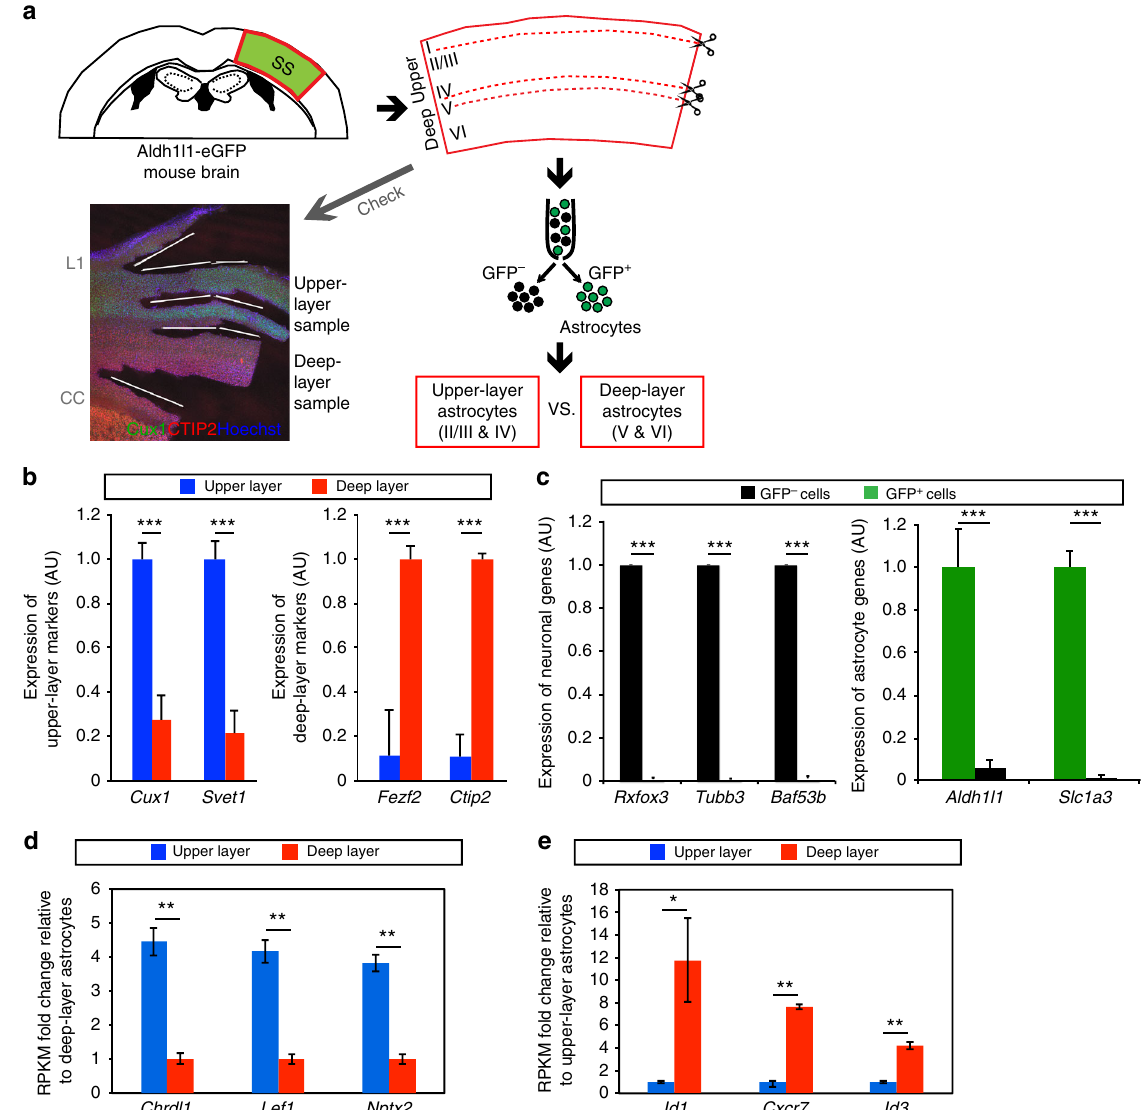
Fig. 4 Layer-speci fi c molecular expression in neocortical astrocytes. a Procedure for the isolation of upper-layer (ULAs) and deep-layer (DLAs) astrocytes for comparison of their gene expression levels. Layer I (L1), the boundary between layers IV and V, and the corpus callosum (CC) are discarded from the somatosensory (SS) area of the brain of young adult Aldh1l1-eGFP transgenic mice in which astrocytes are labeled with GFP and can therefore be isolated by FACS. The fl uorescence image is of a coronal section stained with antibodies to Cux1 and to CTIP2, as well as with Hoechst 33342. b RT-qPCR analysis of upper-layer ( Cux1 , Svet1 ) and deep-layer ( Fezf2 , Ctip2 ) neuronal marker genes in upper-layer and deep-layer tissue samples. c RT-qPCR analysis of neuronal (left) and astrocytic (right) marker genes in isolated GFP + or GFP − cells. d , e RPKM fold change relative to deep-layer ( d ) and upper-layer ( e ) in expression analyzed by RNA-seq ( n = 3 brains). Top 3 upper-layer enriched and deep-layer enriched genes are shown in d , e , respectively. See Supplementary Data 1 and 2 for full gene lists of upper-layer and deep-layer enriched genes, respectively. Data are means ± s.d. for three brains. * P <